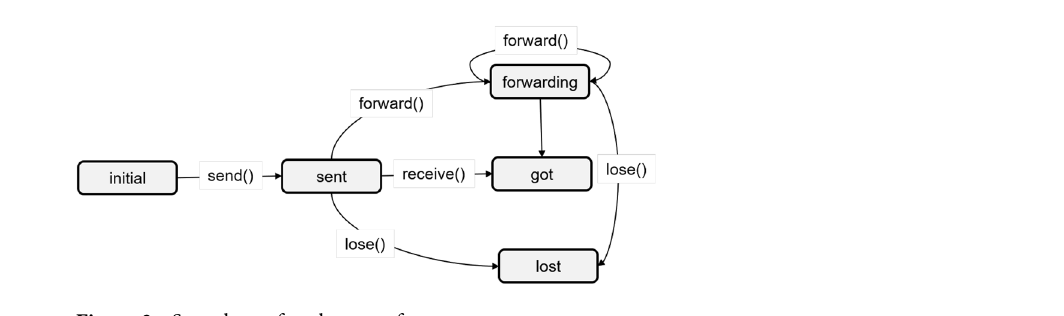
Figure 3. Statechart of packet transfer